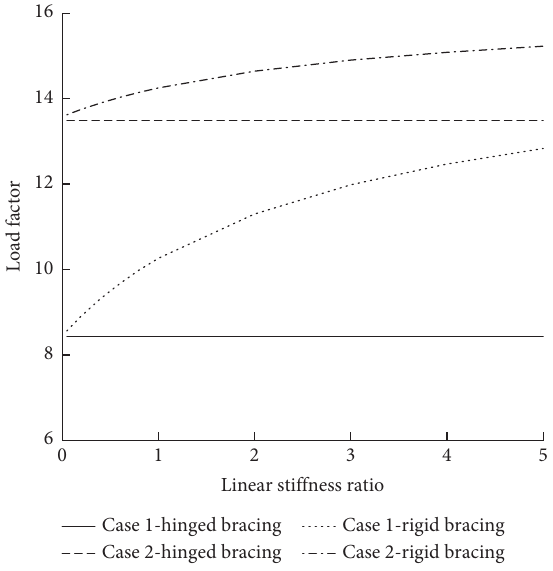
Figure 10: Load factor-linear stiffness ratio (K)